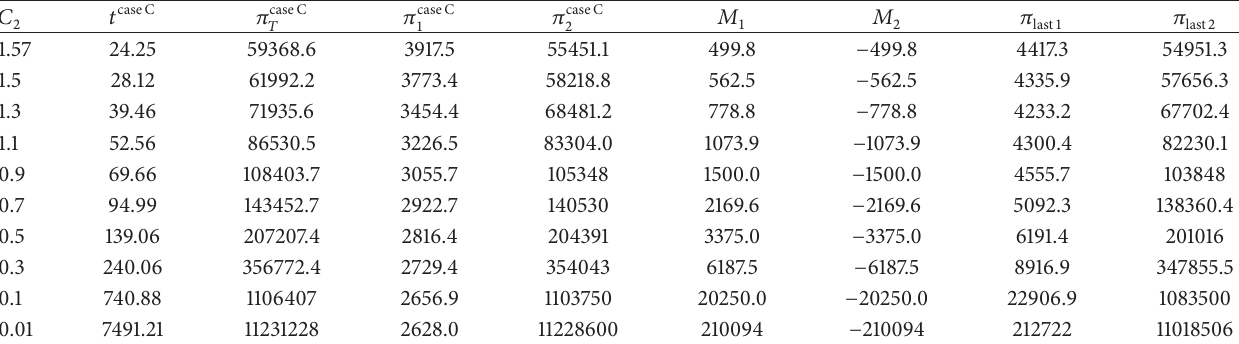
Table 5: The optimal customization degree factor and profit when the customization degree decided by concentrated supply chain, after applying secondary distribution